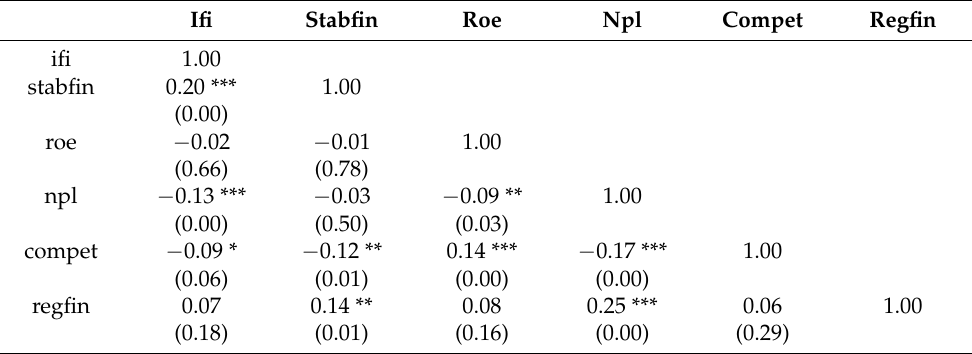
Table A3. Correlation matrix for main variables, SSA sample